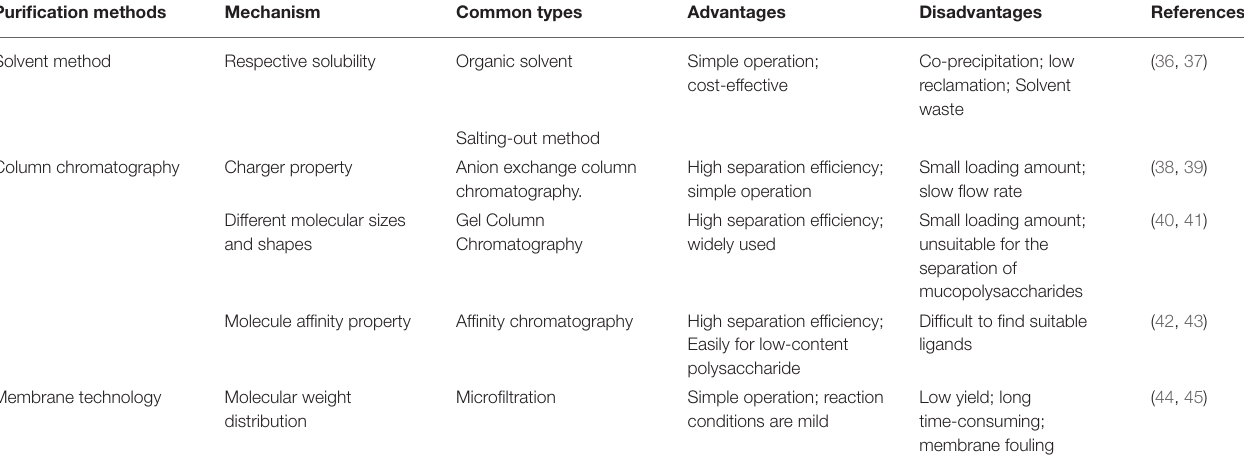
TABLE 2 | Advantages and disadvantages of isolation and purification methods of